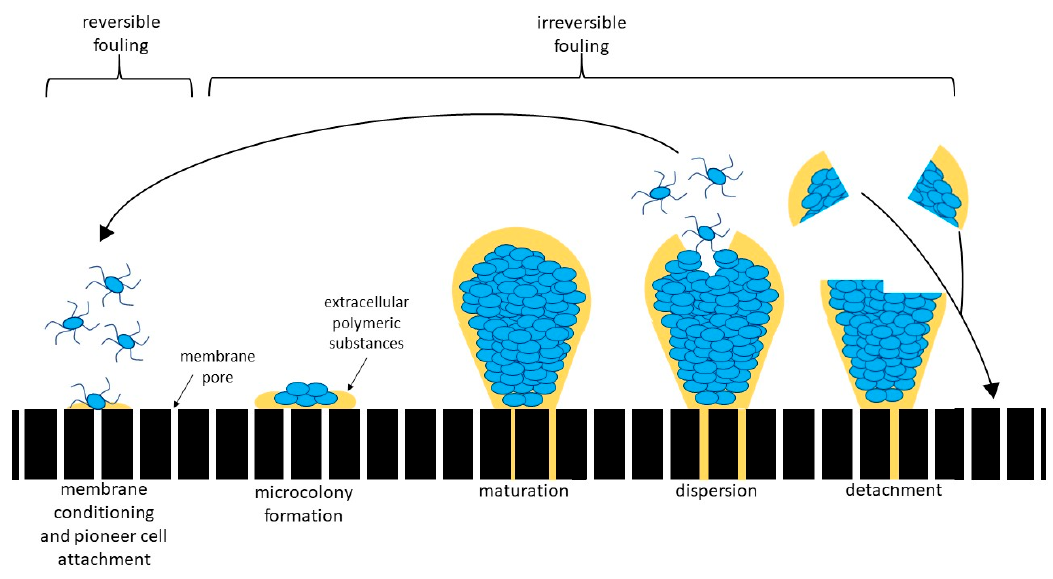
Figure 1. Biofouling occurs via a four-step process: (1) conditioning of the membrane by pioneer organisms or material in the bulk water, (2) attachment of pioneer organisms to the conditioned surface, (3) formation of microcolonies, and (4) formation of a mature biofilm consisting of a community of organisms in a matrix of extracellular polymeric substances (EPS) [26]. Up to 90% of the biofilm consists of the EPS matrix, most produced by the bacteria with in it, with the remaining 10% consisting of the bacterial organisms [9]. Before microcolony formation, biofouling is considered reversible fouling because it can be removed by shear force. However, after microcolony formation, biofilms are too strongly attached to the membrane to detach with increased shear force, therefore, requiring other treatment methods (i.e., chemical treatment).